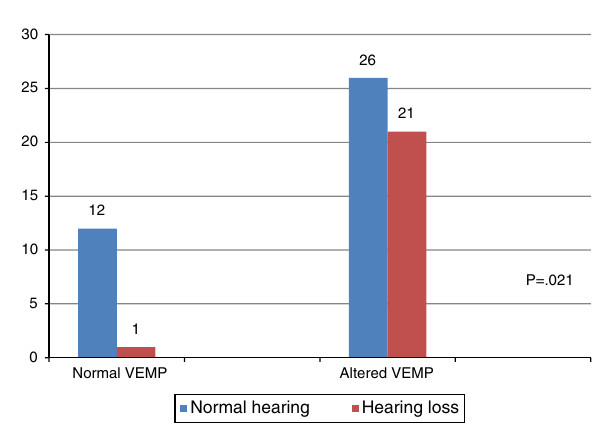
Comparative analysis of the results of combined cer- vical and ocular VEMP and hearing, per ear, for individuals with vestibular hyporeflexia ( n = 60). Chi-squared test ( p ≤ 0.05) or Fisher’s exact test ( p ≤